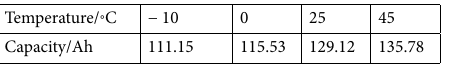
Table 9. Battery capacity in different temperature.